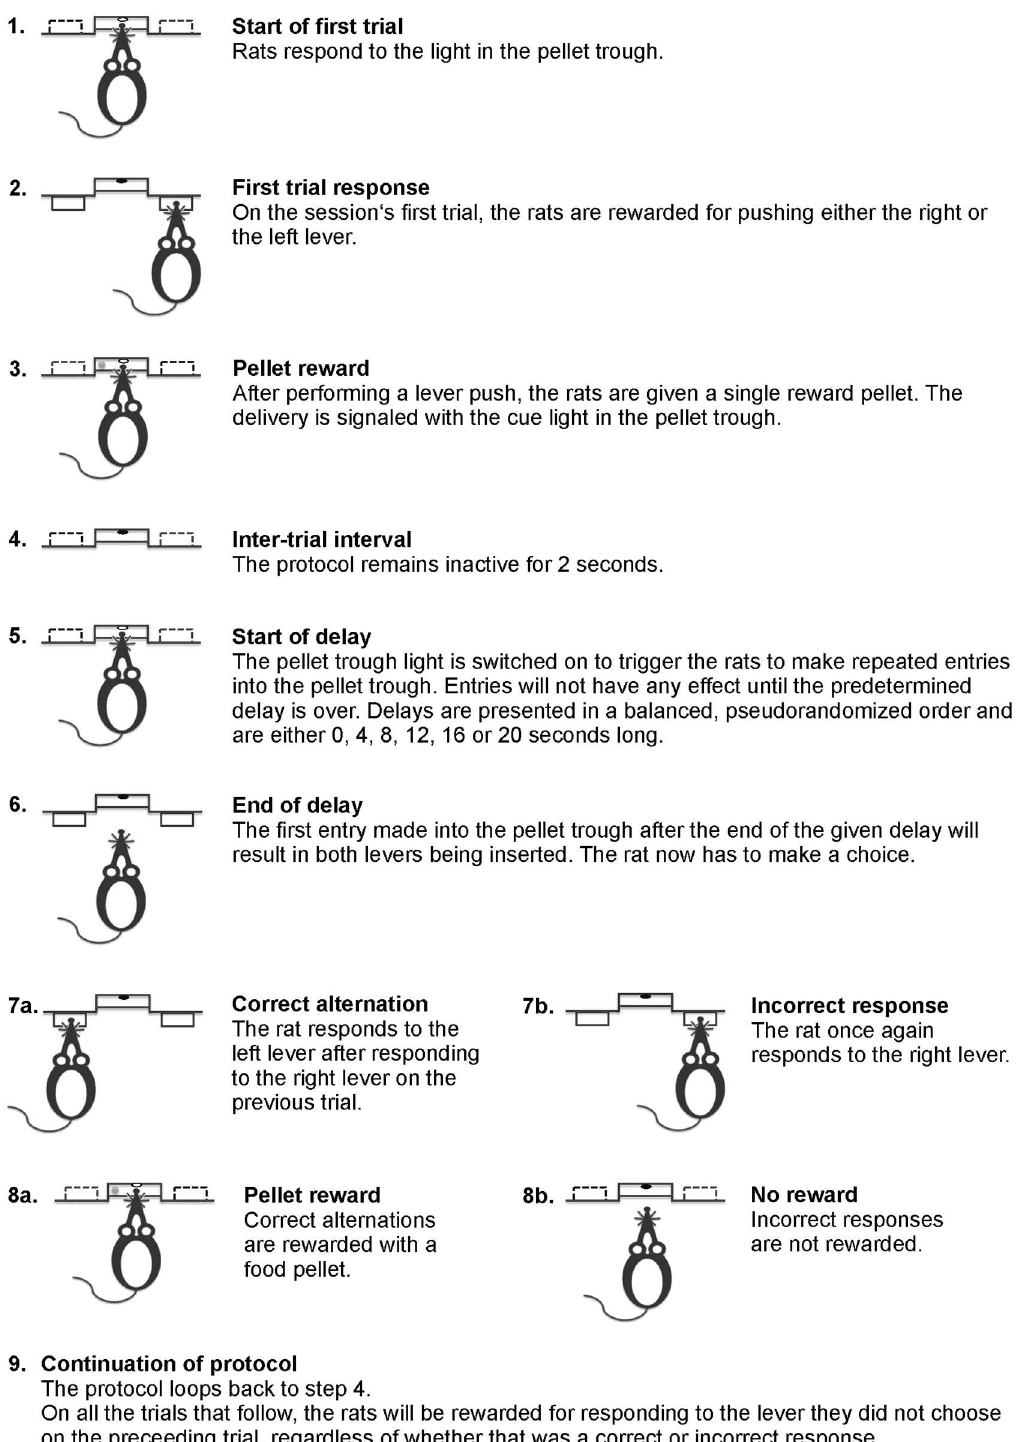
Fig 1. Delayed alternation protocol. The figure describesthe steps that make up individual trials in the delayed alternationtest.